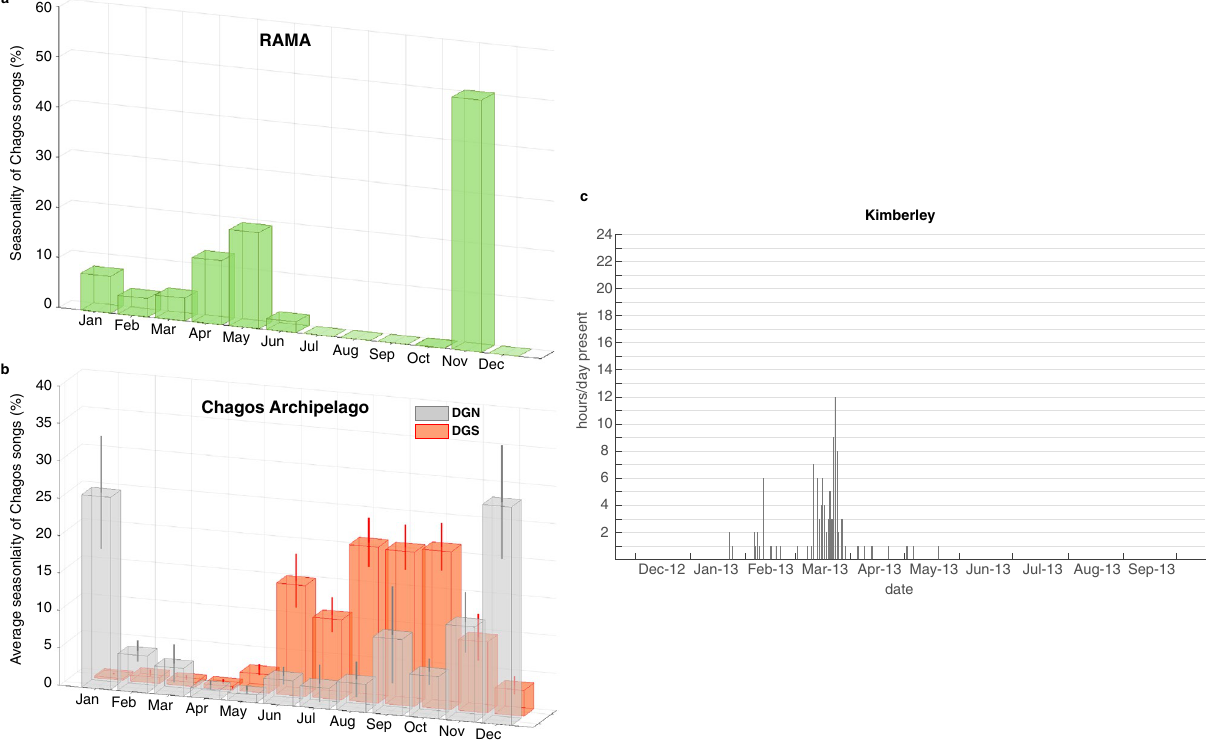
Figure 9. ( a ) Seasonality of Chagos songs at RAMA in 2013, presented as a percentage of songs per month ( i.e. monthly number of songs divided by total number of songs detected in the year); ( b ) Seasonality of Chagos song averaged over the years (±SE) on the western (DGN—gray) and eastern (DGS—orange) sides of the Chagos Archipelago. This average seasonality is calculated as such: the monthly number of songs is divided by the total number of songs detected in the corresponding year, and averaged over the years. Note that due to the low number of recording days at DGN in 2007 and 2014, and in 2007 at DGS, these years were removed from the averaging (DGN: 11 years and DGS: 15.5 years); ( c ) Hourly presence of Chagos songs in Kimberley (Western Australia) in 2012–2013. Note that the metric and thus the graphic representation used for this site is different from that for RAMA and DGN/DGS: in the Kimberley data set, Chagos songs were logged upon visual inspection of the spectrograms, and a metric of hourly presence/absence of the song per day was used (see the Methods section for details).